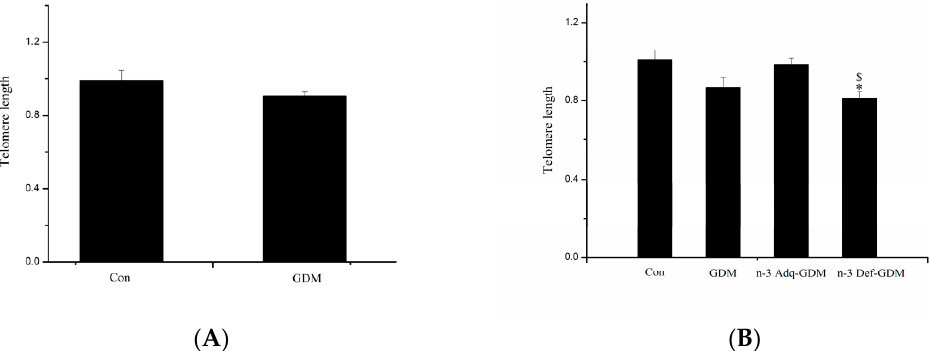
Figure 5. Influence of gestational diabetes mellitus (GDM) on telomere length (TL) of the liver of offspring and the effect of n-3 polyunsaturated fatty acids (n-3 PUFA) and n-6 PUFA on telomere length of the liver of GDM offspring. ( A ) At weaning; ( B ) at 11 months. n =8 rats/group. * p < 0.05, vs. Control offspring (Con); $ p < 0.05, vs. n-3 Adequate-GDM offspring (n-3 Adq-GDM).